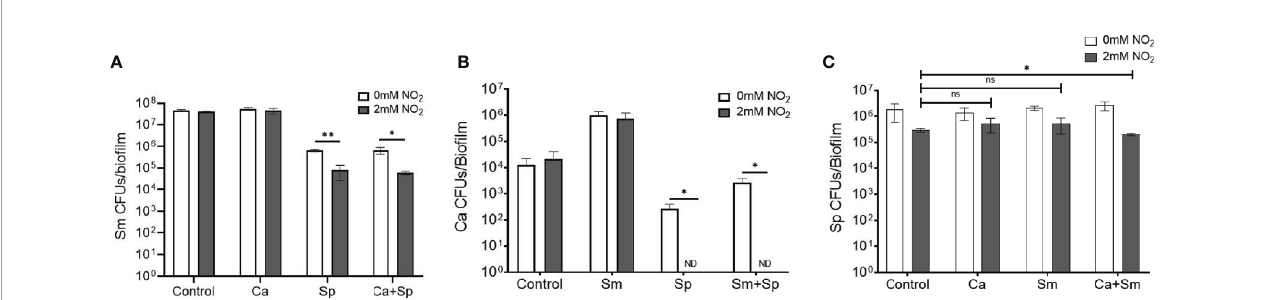
FIGURE 1 | S. parasanguinis reduces S. mutans and C. albicans bio fi lm formation in a nitrite-dependent manner. Colony forming units of 16-hour single-, dual-, and tri-species bio fi lms with or without 2mM NO 2 . (A) S. mutans (Sm), (B) C . albicans (Ca), and (C) S. parasanguinis (Sp). All bio fi lms were grown for 16 hours in tryptic soy broth containing 0.5% yeast extract and 1% sucrose. *p < 0.05, **p < .001, and ns, not signi fi cant. ND, not detected. (Student ’ s t-test) Data are representative of 3 biological replicates that contained 3